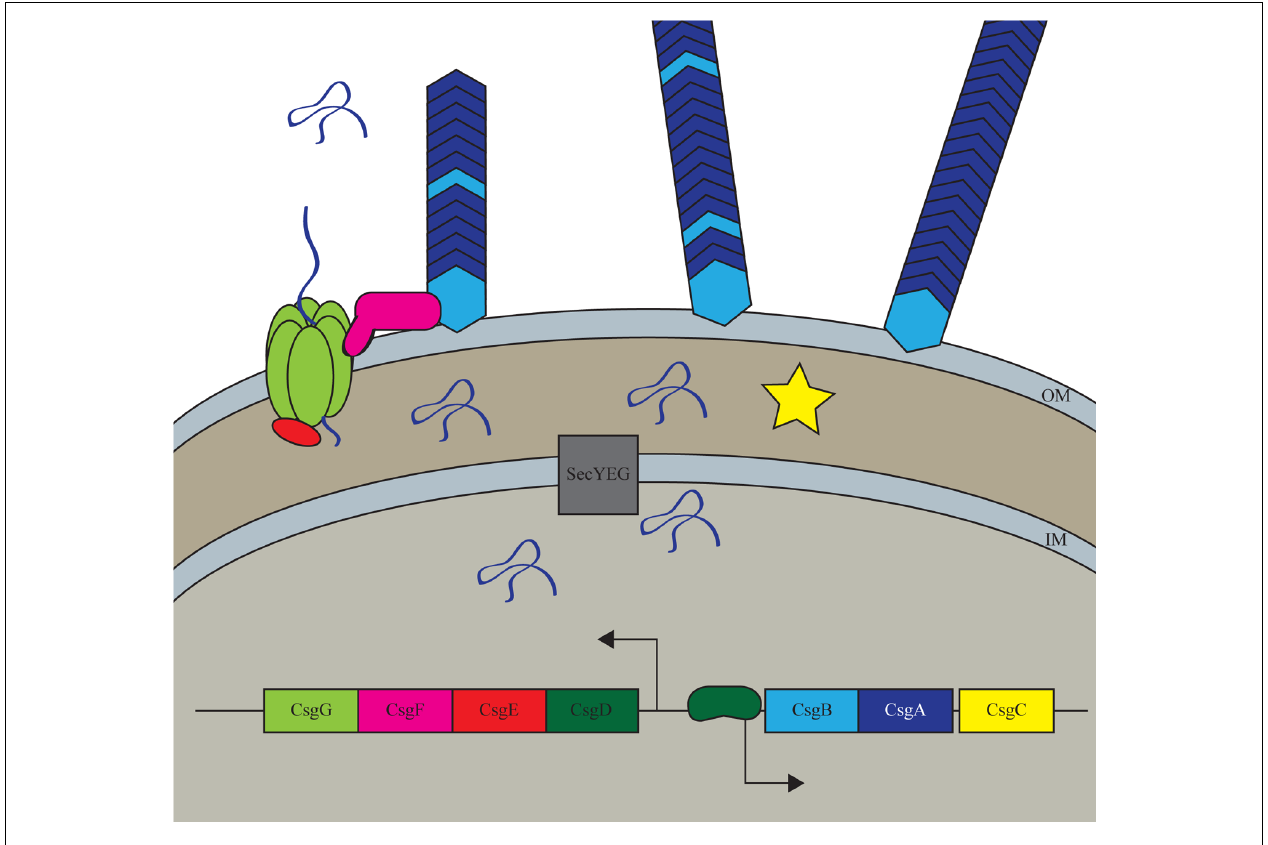
CsgD are secreted through the Sec secretion pathway into the periplasm where CsgA, CsgB, and CsgF are then transclocated outside of the cell through the CsgG pore complex. CsgE and CsgF aid in proper export and localization of the structural components while CsgC has a less well understood role in the